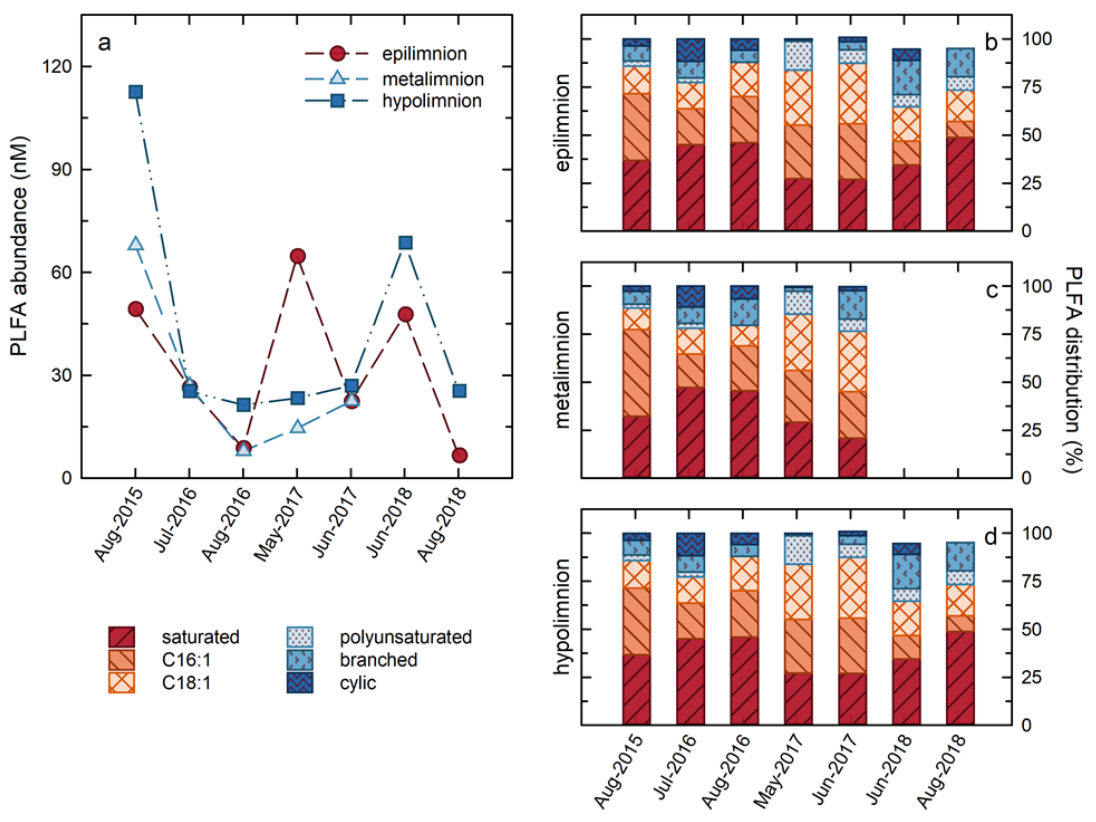
Figure 5. Total PLFA concentrations for the epilimnion, metalimnion, and hypolimnion over the course of the study (panel ( a )). Distribution of PLFA groups in the epilimnion ( b ), metalimnion ( c ), and hypolimnion ( d ) over the course of the study.